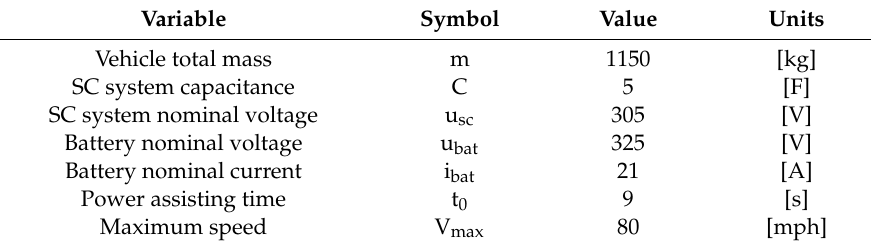
Figure 15. Acceleration and power tests: ( a ) Acceleration tests; ( b ) Power tests. Table 2. Vehicle, Battery and SC